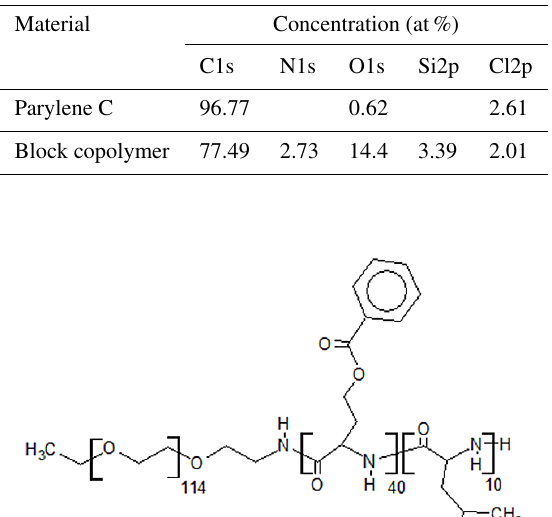
Table 1. Experimental data of XPS measurements.